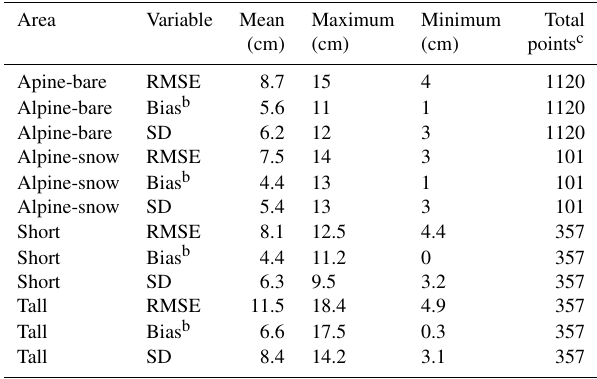
Table 2. Absolute surface accuracy summary a .